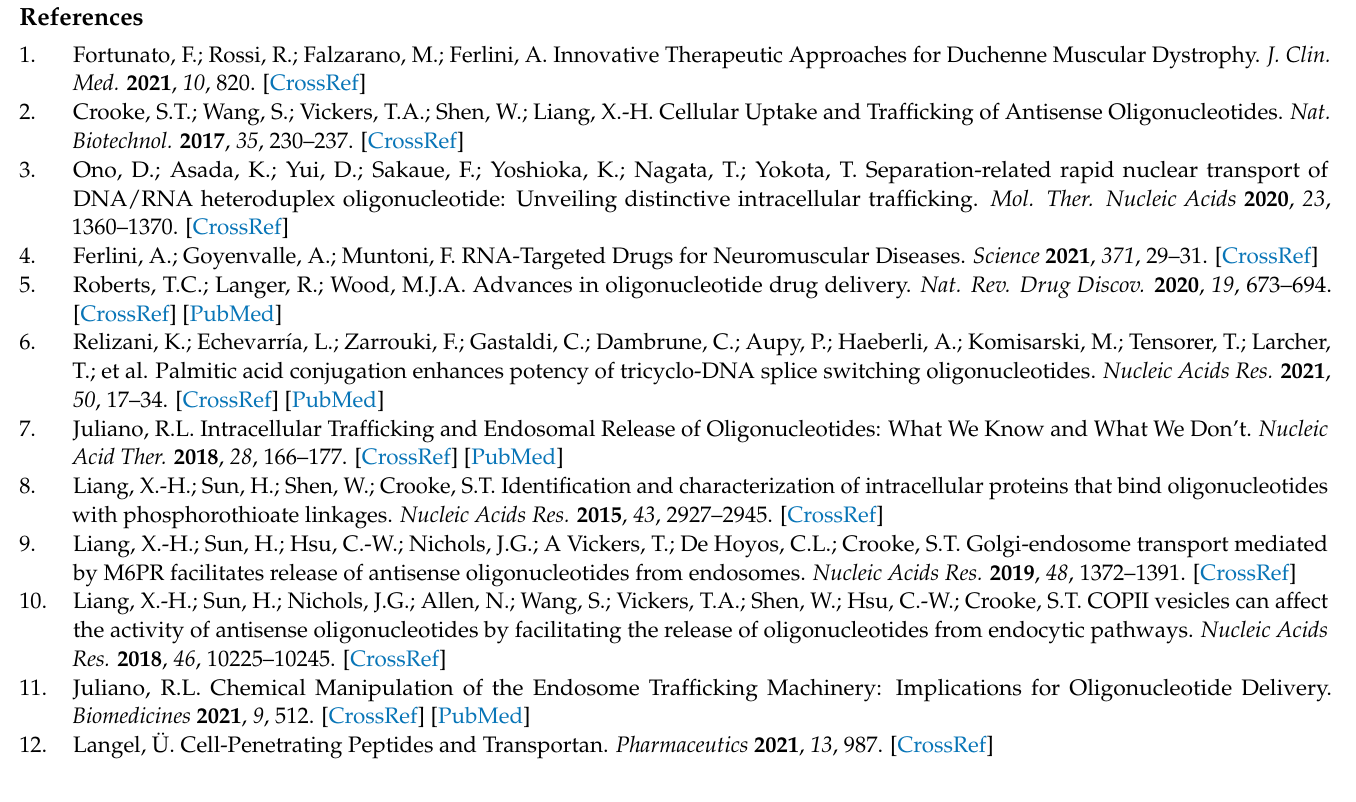
Figure S3: Comparison between 1 vs. 4 injections of UNC7938 on exon skipping efficacy, Figure S4: Treatment with UNC7938 alone has no effect on dystrophin